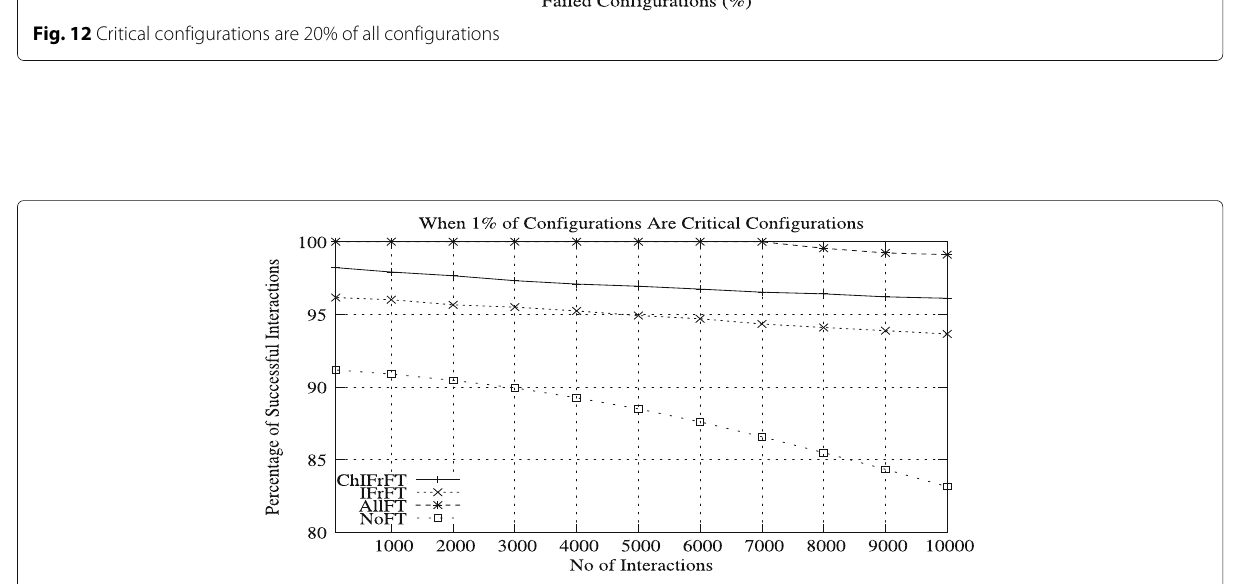
Fig. 13 Critical configurations are 1% of all configurations